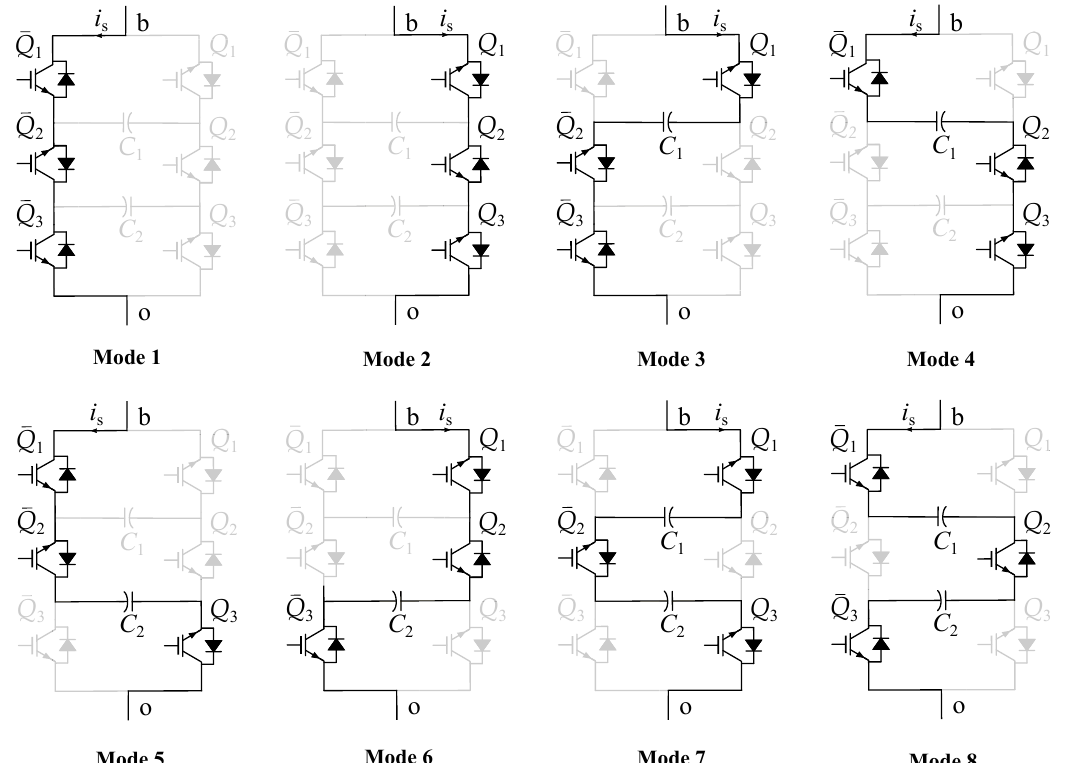
Figure 4. Switching modes of cascaded converter